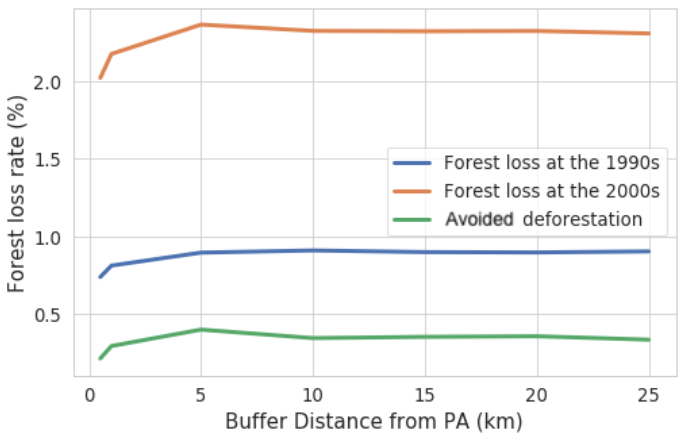
Figure 5. Mean forest loss rate in surrounding areas at various buffer distances in the 1990s and in the 2000s.